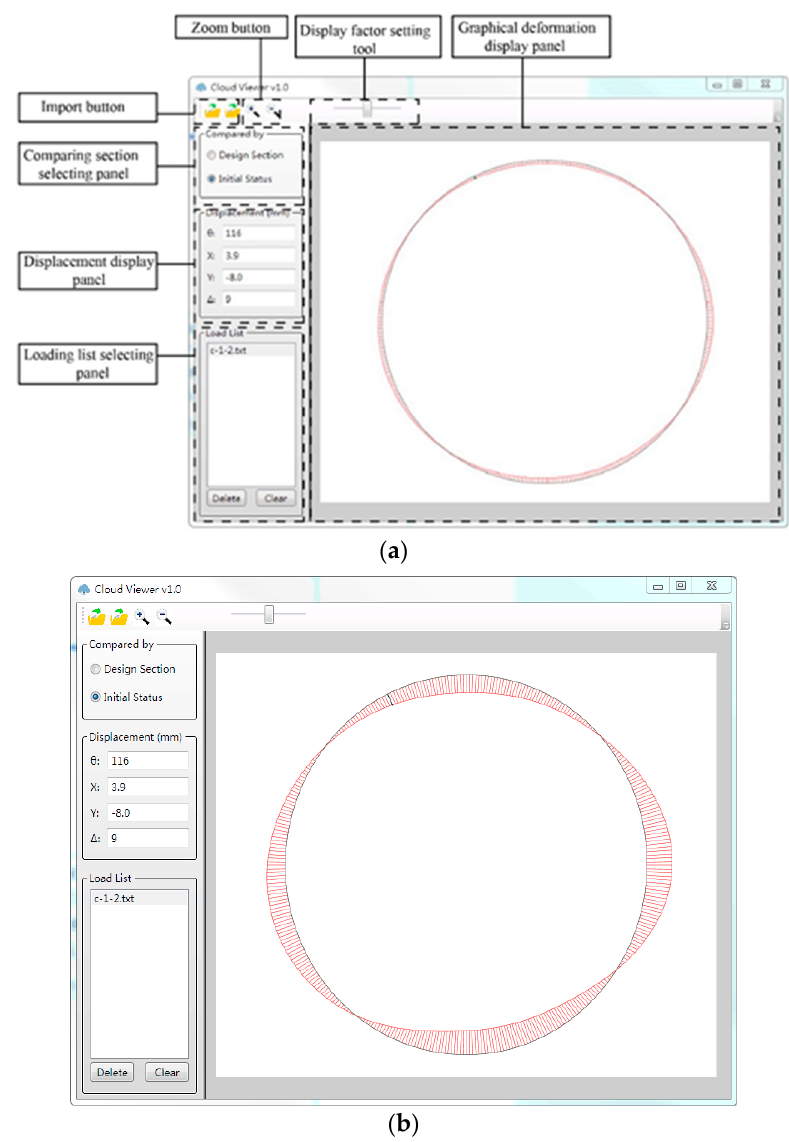
Figure 6. GUI of Cloud Viewer showing deformation visualized by multiplying different display factors: ( a ) display factor of 1.0; and ( b ) display factor of 4.